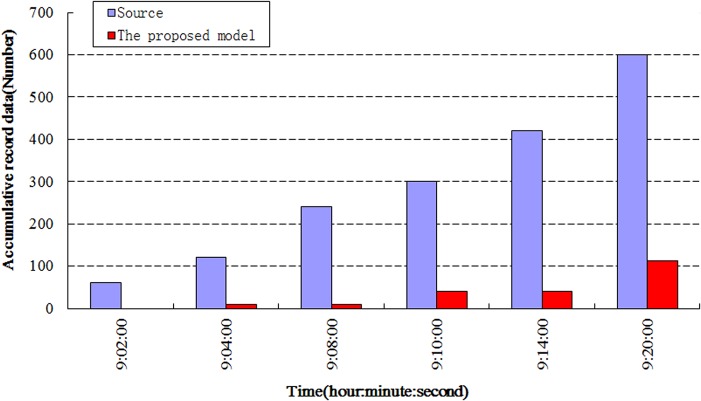
Comparative histogram of data storage.